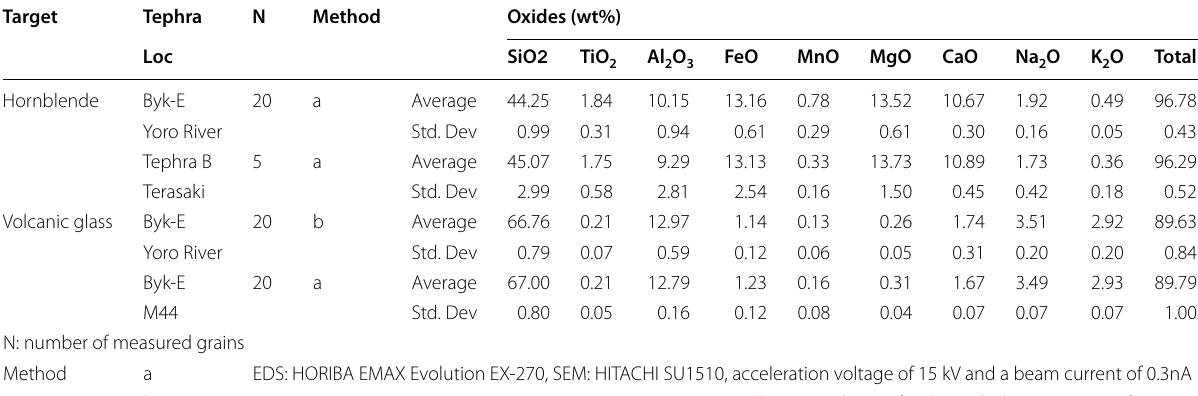
Table 1 Chemical analysis of a tephra layer (tephra B) from Terasaki section (this study), Byk-E from Yoro river (the Chiba section) and Byk-E from M44 section (Nanayama et al.